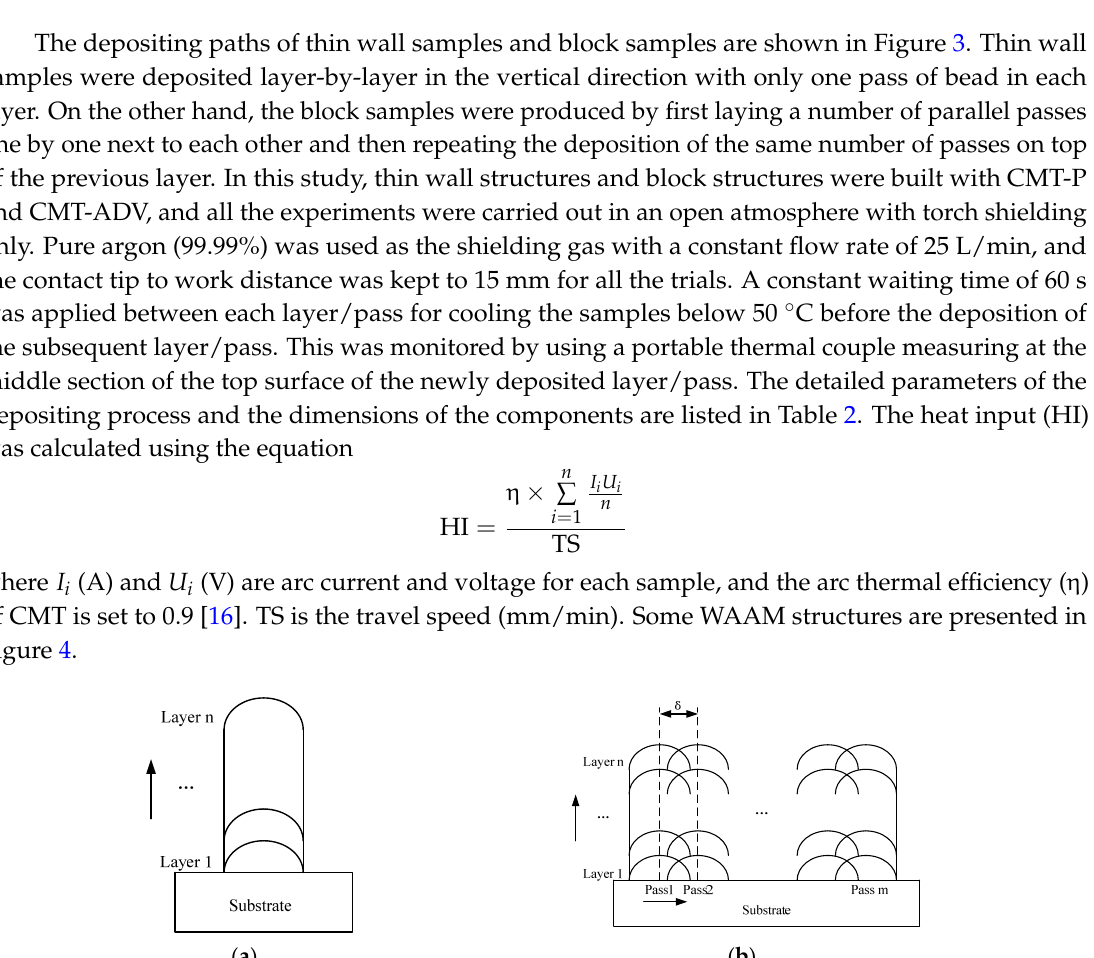
Figure 3. The depositing paths for ( a ) thin wall samples and ( b ) block samples.